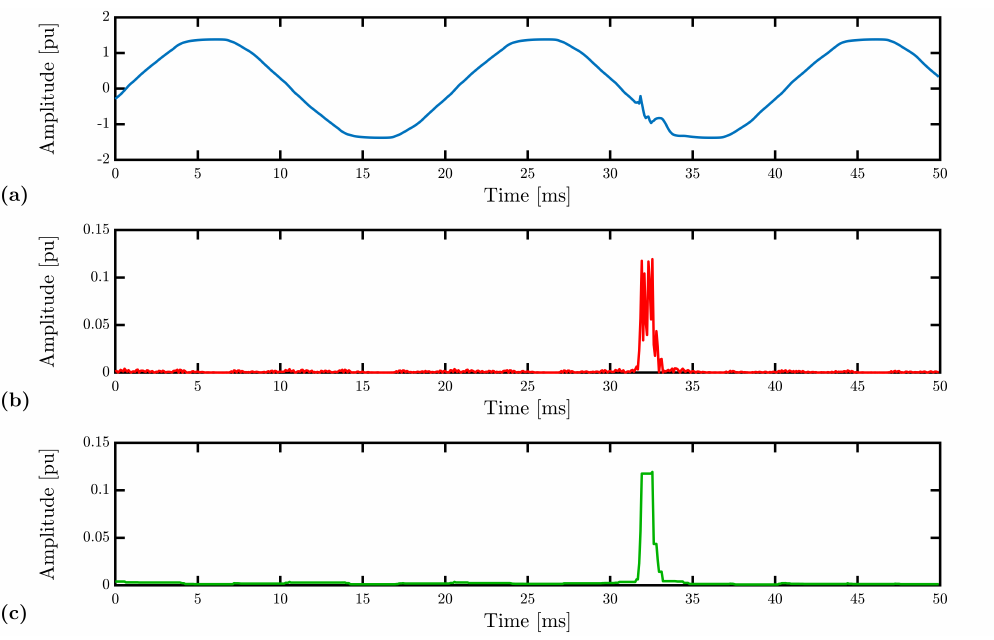
Figure 2. Example of transient detection and characterization using the high-pass filter and closing morphology operation. The input segment is represented in ( a ) while the absolute values of the filter output are presented in ( b ). The result of the closing morphological operation is depicted in ( c ).